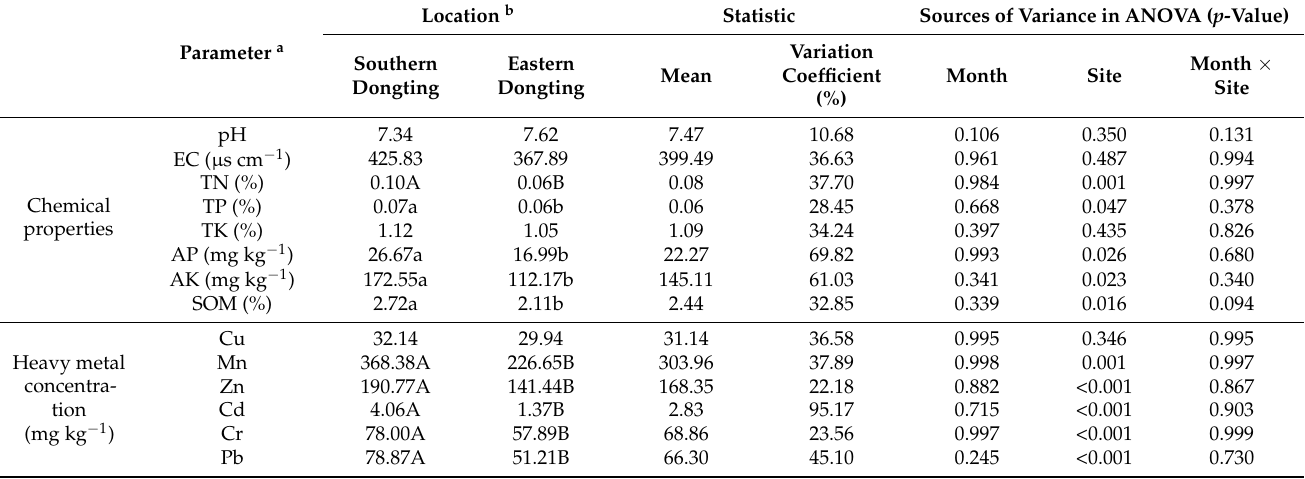
Table 1. Soil chemical properties and heavy metal concentrations in the study